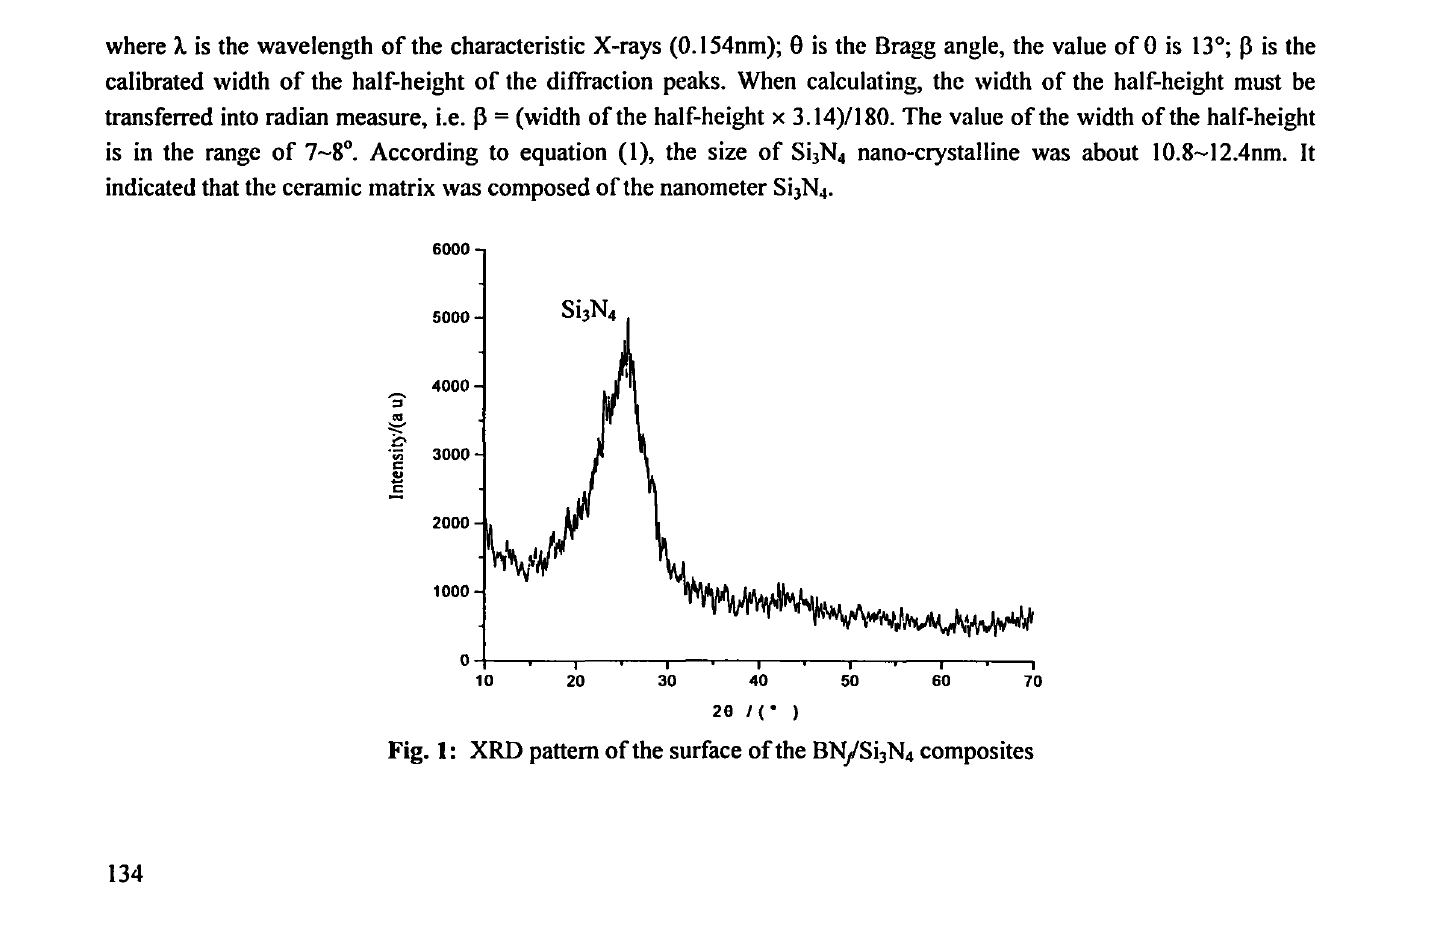
Fig. 1: XRD pattern of the surface of the BN/Si